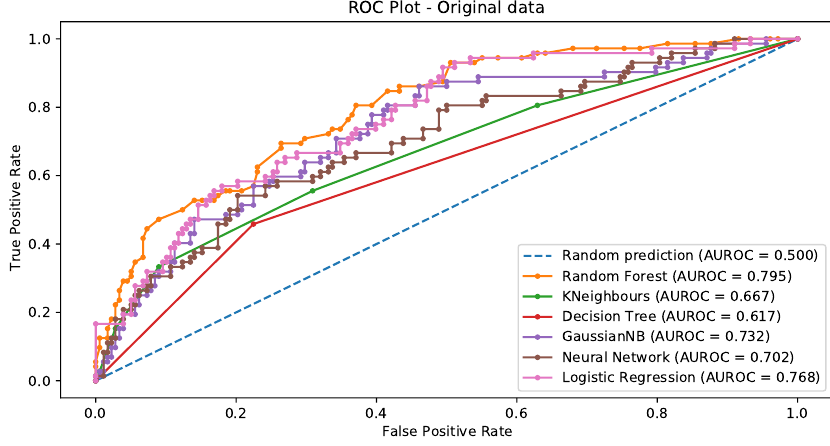
Figure 7. Imbalanced data.